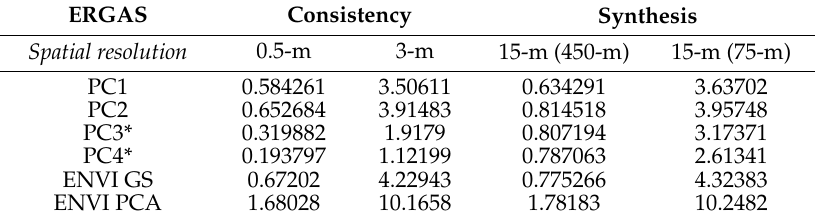
Table 6. ERGAS values for ASTER dataset.* Sharpened images for synthesis property were created from synthetic images where the PAN was degraded to the resolution of the original MUL (15-m) and the MUL was thereafter degraded to 450-m and 75-m respectively in order to keep the same spatial resolution ratio. For ERGAS, the best possible result is zero, which indicates two identical images. It was expected that the first two PCs have the potential to give good results when employing the PCA sharpening process, however PC3* and PC4* were used to compare the result and explain it in a wider context.